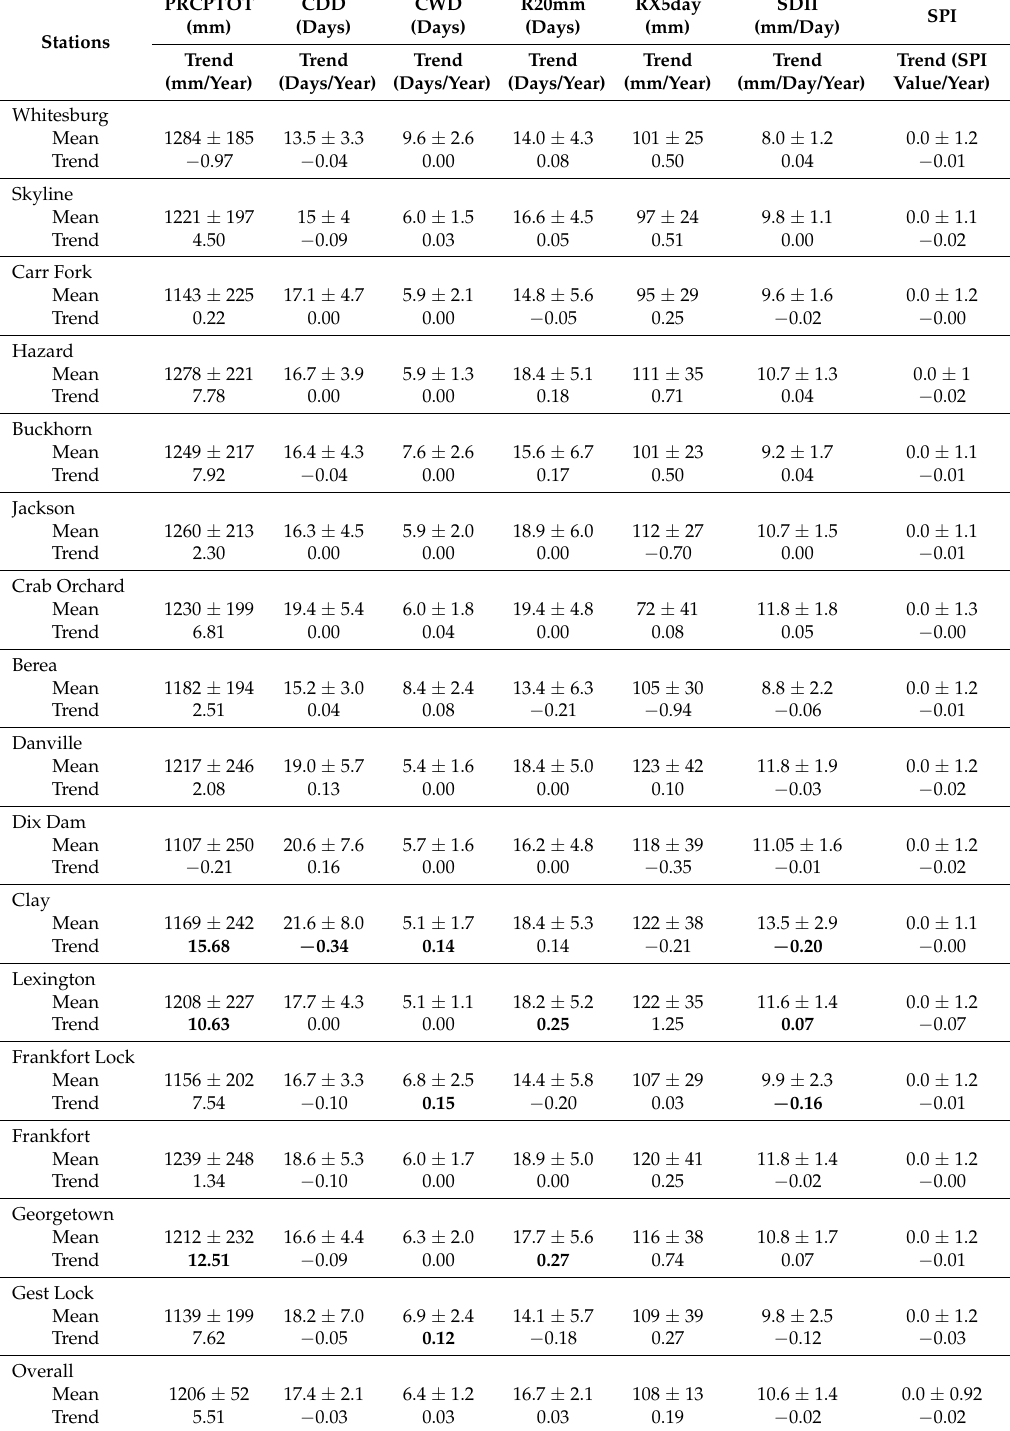
Table 5. Mean annual index values with standard deviation and Sen slope estimates. Bold values indicate a significant ( p < 0.05)